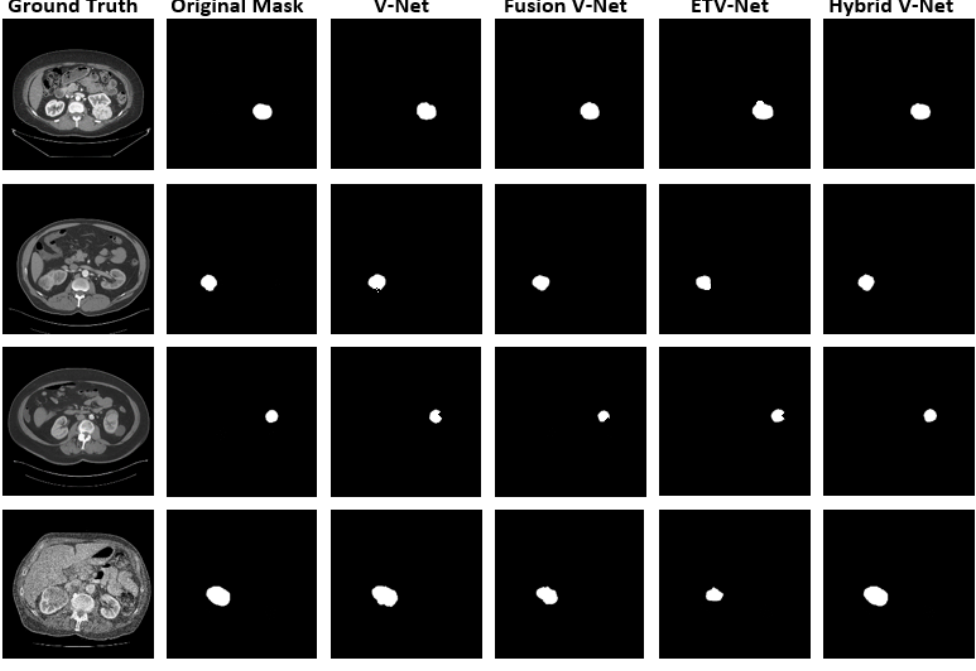
Figure 13. Original input CT images and kidney tumor segmentation output images.